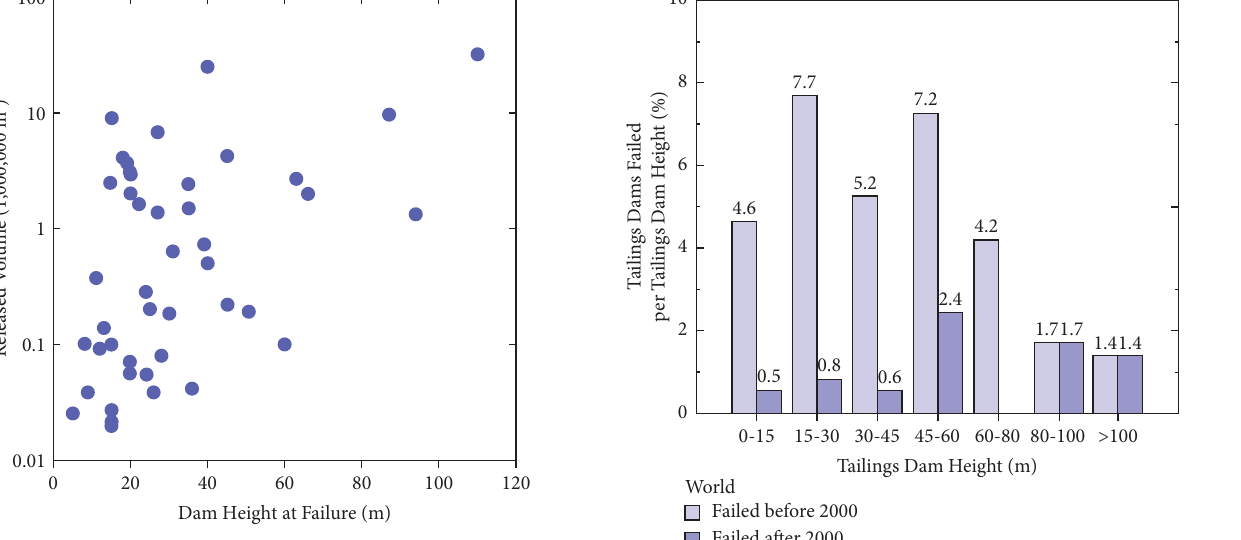
Figure 16: Released volume as a function of dam height at failure (data from Rana et al. [72]).